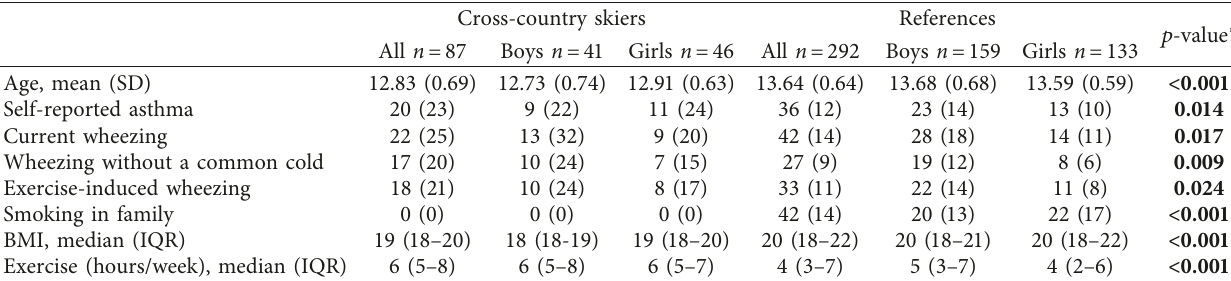
Table 1: Demographic and clinical characteristics of Swedish cross-country skiers in early adolescence and a population-based reference group.